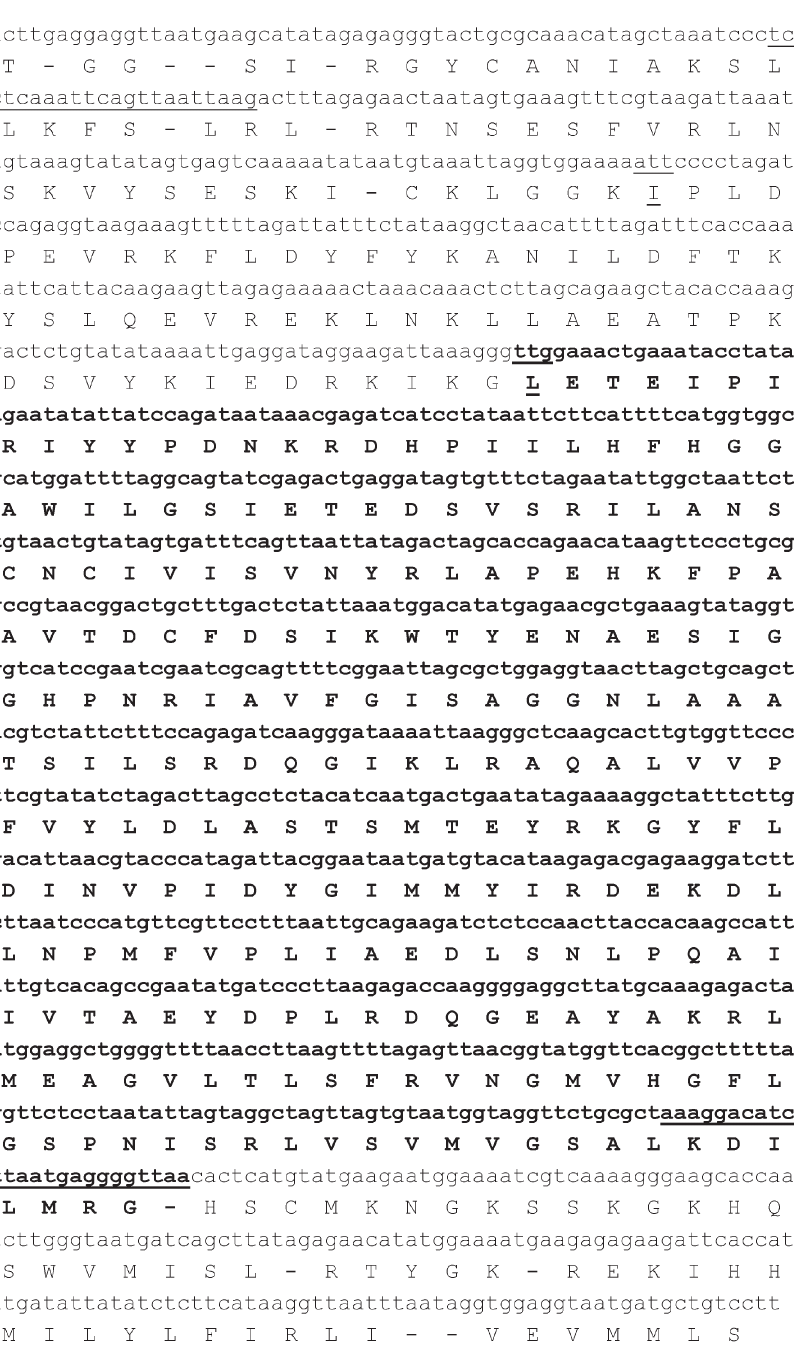
Figure 1. Nucleotide sequence of the S . solfataricus Sso N Δ gene (in bold), and its upstream sequence, reported from the S . solfataricus P2 genomic database. The predicted amino acid sequence is given below the nucleotide sequence in the stan- dard one-letter code. The oligonucleotides used to amplify the gene from the genome for re-sequencing are underlined. The se- quence between oligonucleotides was con- firmed by re-sequencing. The start site for Sso N Δ long is